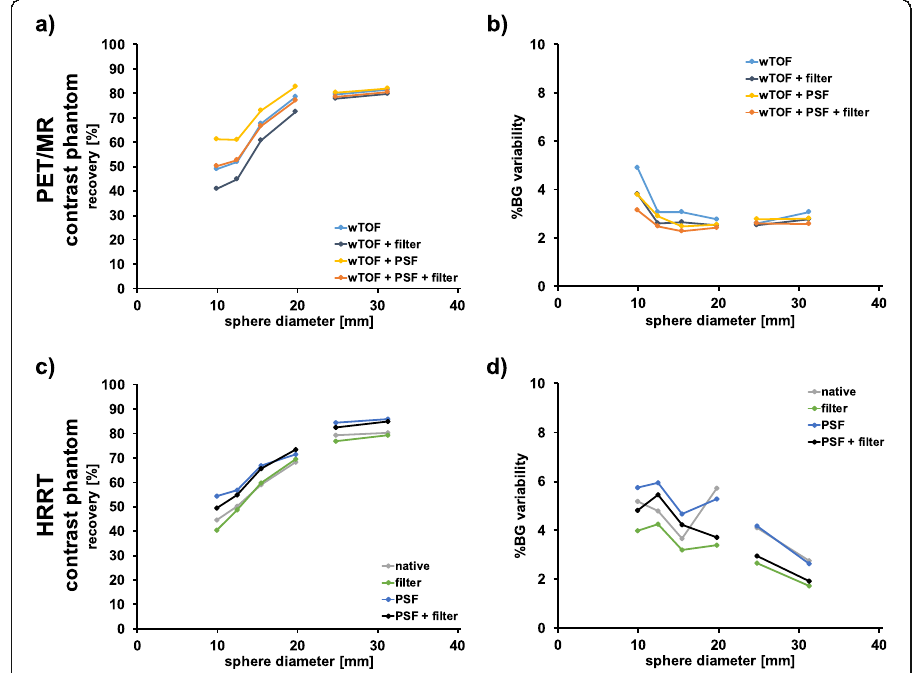
Fig. 2 RCs and %BG variability as a function of sphere diameter for the contrast phantom (PET/MR: RCs ( a ), %BG variability ( b ); HRRT: RCs ( c ), %BG variability ( d )). PET/MR data were reconstructed with TOF, TOF with filter, TOF with PSF, and TOF with PSF and filter. Two iterations and 28 subsets were used, respectively (GE recommendation for phantom data). HRRT data were reconstructed without any filters (native), with a 2-mm Gaussian filter (standard in- house reconstruction for human data) using 6 iterations and 16 subsets, respectively, with PSF, and with PSF correction and 2-mm filter using 10 iterations and 16 subsets, respectively. Note the gap between spheres marks cold vs. hot spheres